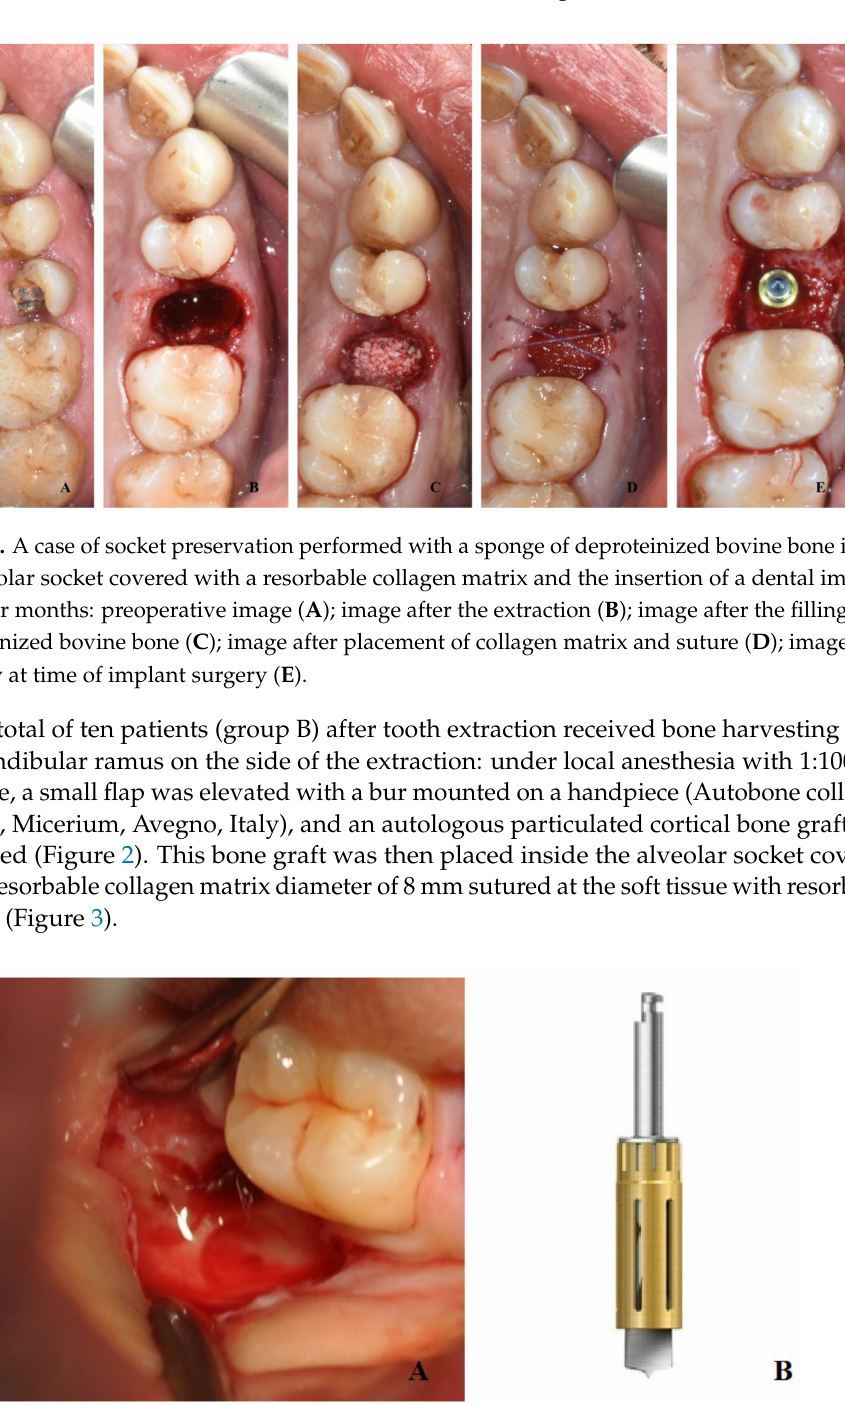
Figure 2. The figure shows bone harvest from the mandibular ramus performed with bur mounted on a handpiece ( A ); detail of the bur used for this procedure ( B